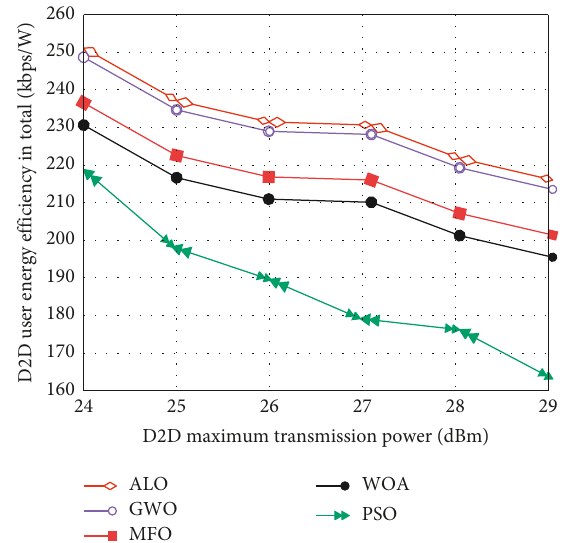
Figure 5: The graph of the D2D user energy efficiency summation as a function of the D2D maximum transmission power P max